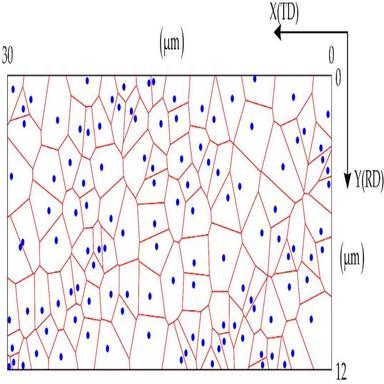
Pseudorandom 2D grain geometries.